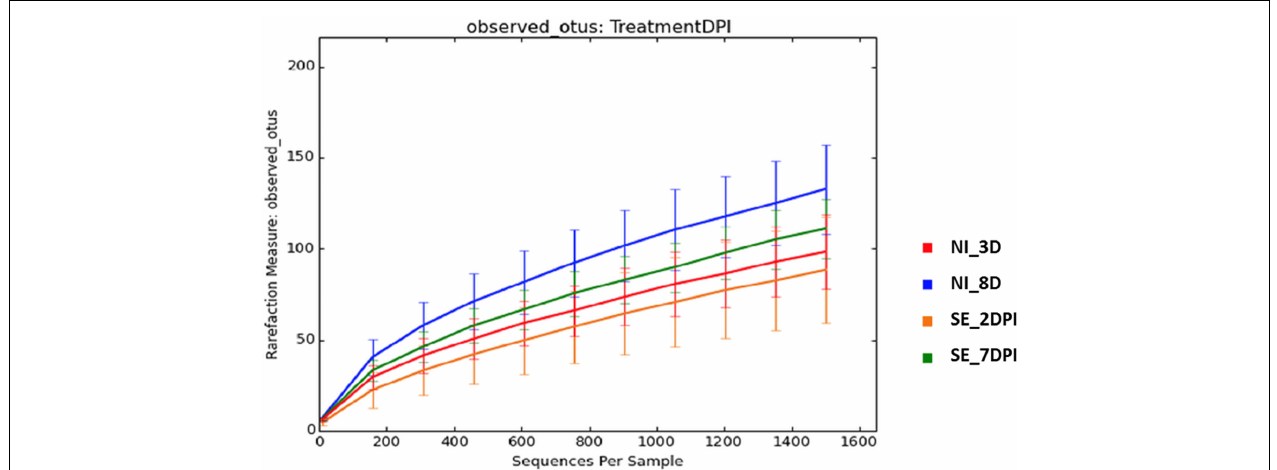
FIGURE 9 | Rarefaction curves of number of observed OTUs based on 97% sequence similarities for treatment group at different time points . Abbreviations: NI_3D, non-infected chicks at 3days old; NI_8D, non-infected chicks at 8days old; SE_2DPI, S. Enteritidis-infected chicks at 2days post infection; SE_7DPI, S. Enteritidis-infected chicks at 7days post infection.